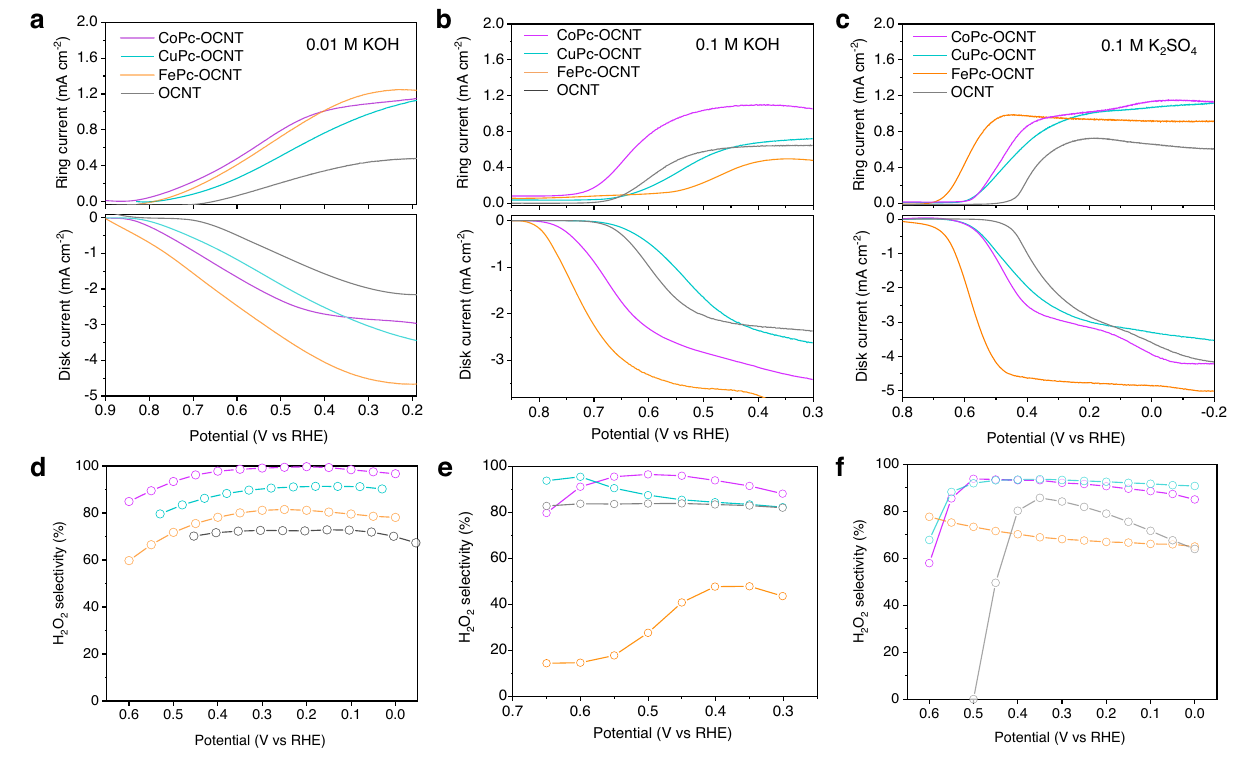
Fig.3|Two-electronORRactivityandselectivityevaluationoftheTMPc-OCNT catalystsusingRRDE. LinearsweepvoltammetryshowthatORRandsimultaneous H 2 O 2 oxidization currents are achieved on disk and ring electrodes,